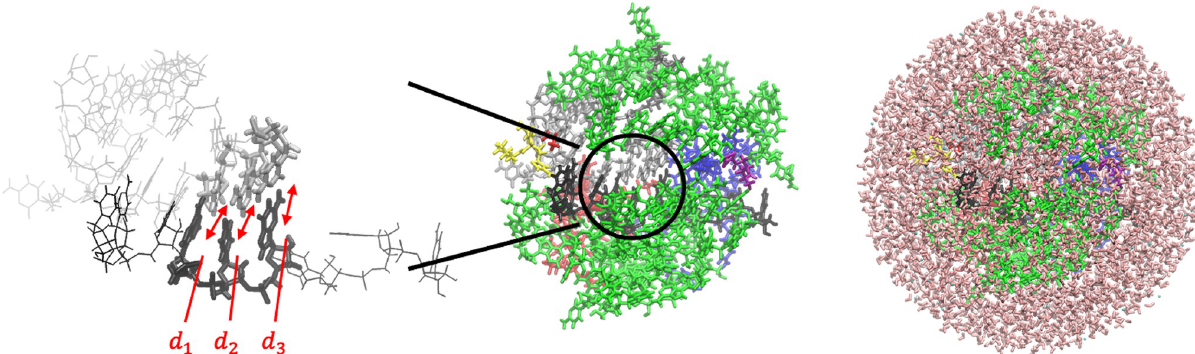
Fig 1. PIC structure models and reaction coordinates in this study. (Left) mRNA and tRNA around the codon-anticodon base-pairs (Table 1) are shown in black and silver, respectively. Distances d 1 , d 2 and d 3 used as reaction coordinates are indicated. (Center) rRNA segments (split) are shown in green, and protein components are shown in other colors. (Right) Water molecules are shown in pink, which enclose the system and form a sphere.